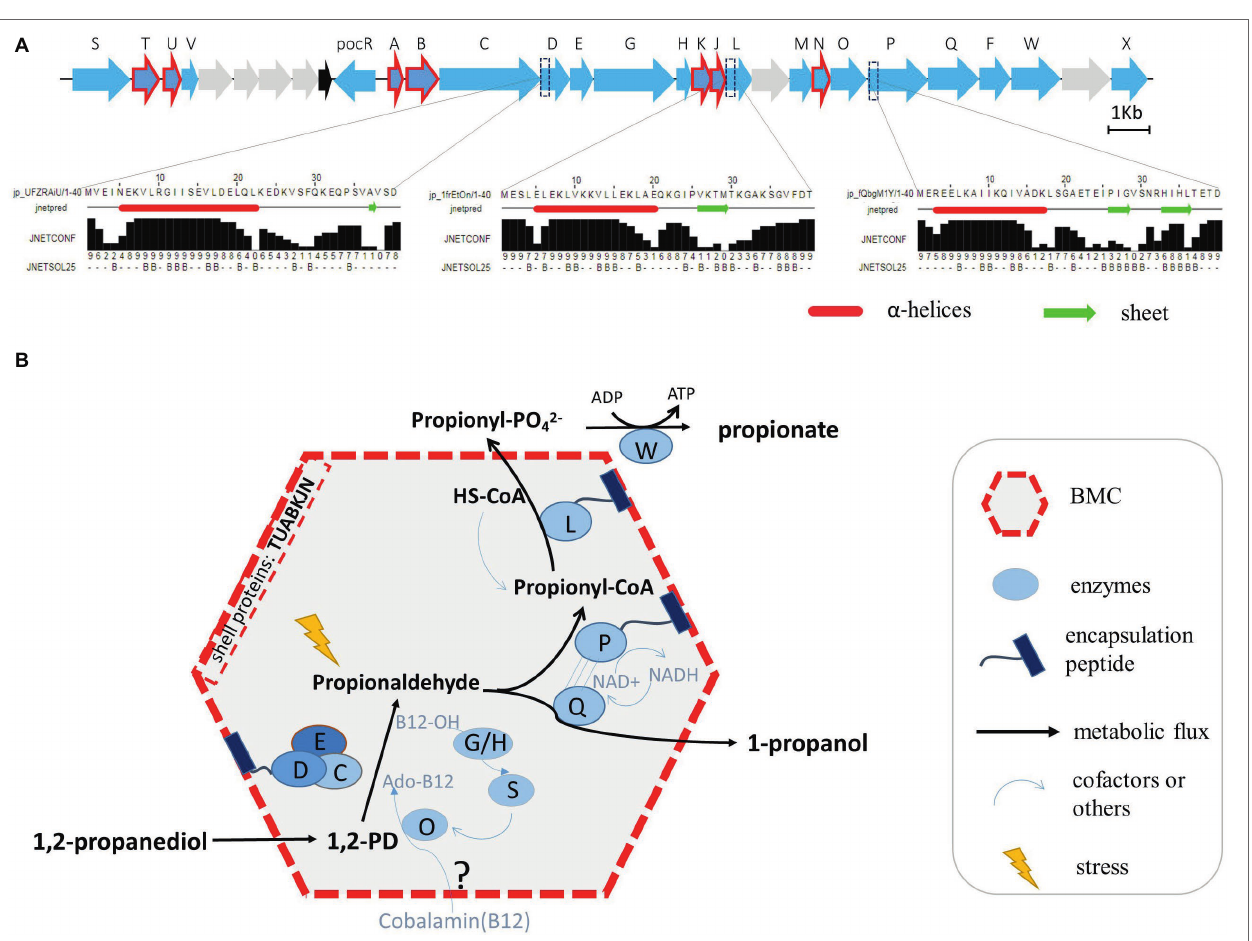
FIGURE 4 | Prediction of N terminal encapsulation peptides (A) and the corresponding model of BMC-dependent metabolism of Pd catabolism in Listeria sensu stricto (B) . (A) Pdu enzymes and corresponding reactions, with the predicted N-terminal encapsulation peptides of PduD, PduP, and PduL indicated, with alpha helices marked as red tubes and sheets as green arrows. Jnetconf: confidence estimation for the prediction with high scores indicating high confidence. Jnetsol25: solvent accessibility, where B means buried and ‘-’ means non-buried at 25% cut-off. (B) Model of the proposed BMC-dependent Pd metabolism in Listeria sensu stricto. PduCDE, B12-dependent diol dehydratase; PduP, CoA-dependent propionaldehyde dehydrogenase; PduGH, diol dehydratase reactivase; PduO, corrinoid adenosyltransferase; PduS, cobalamin reductase; PduL, phosphate propanoyltransferase; PduW, propionate kinase; PduQ, propanol